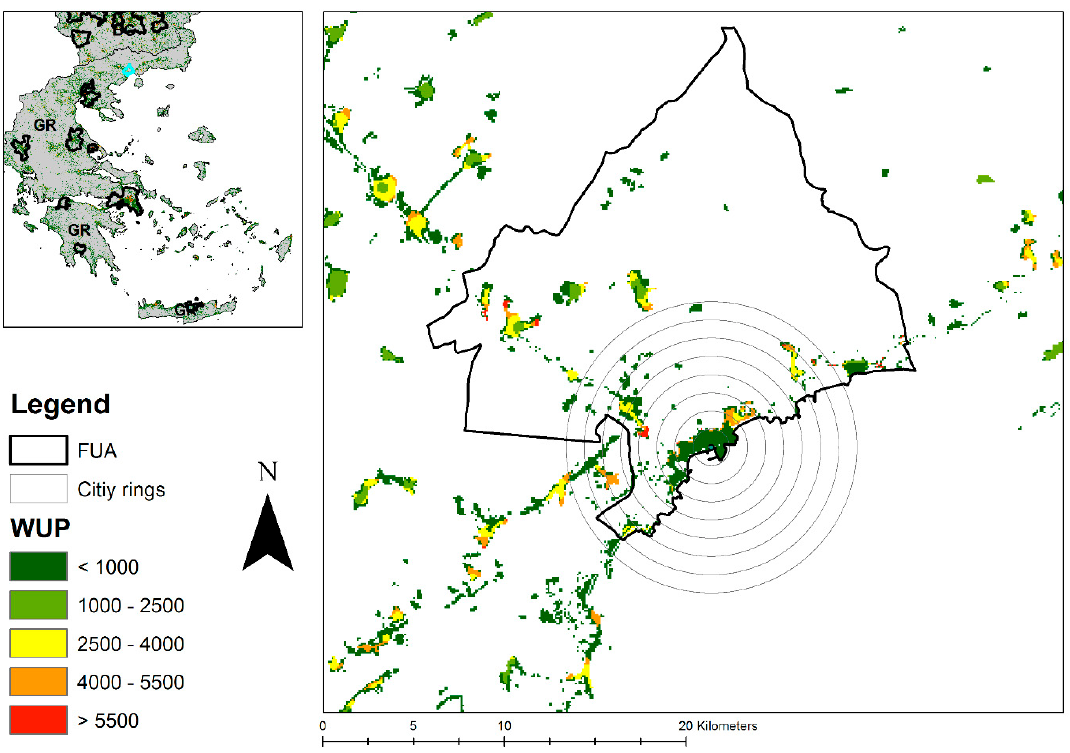
Figure 14. ACWUP for the city of Kavala, Greece (using an 8 km edge).